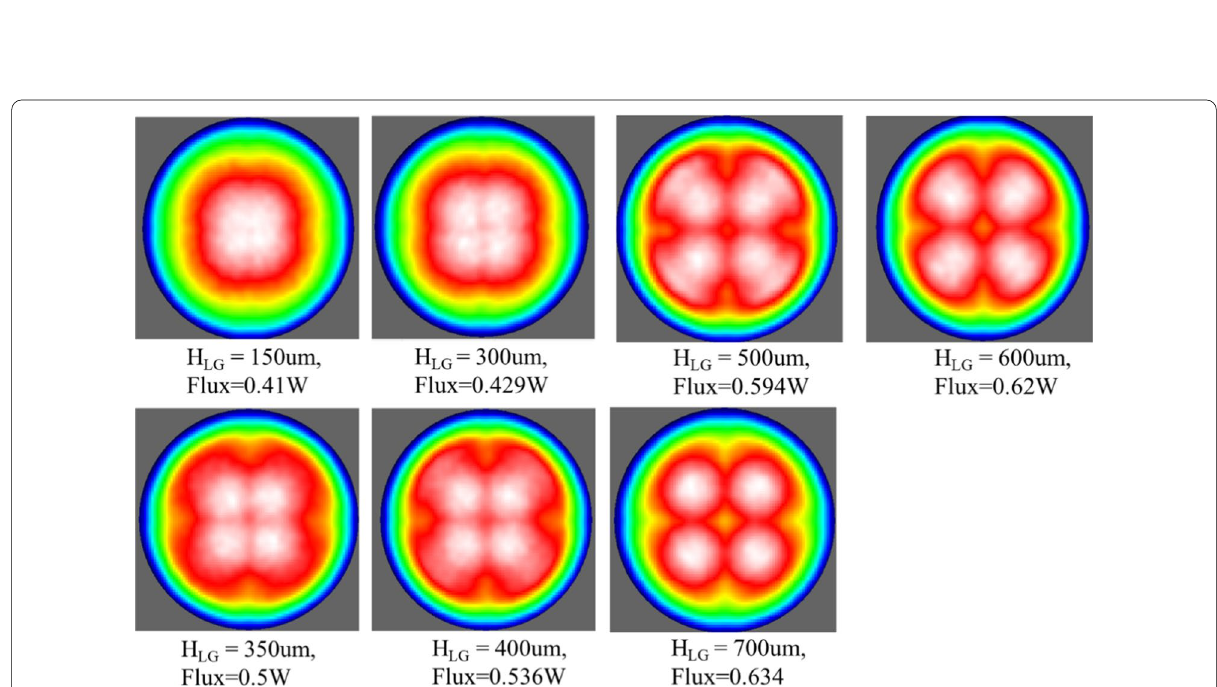
Fig. 5 LEE diagram of the simulated UV‑C LED light guide with a thickness of 150–700